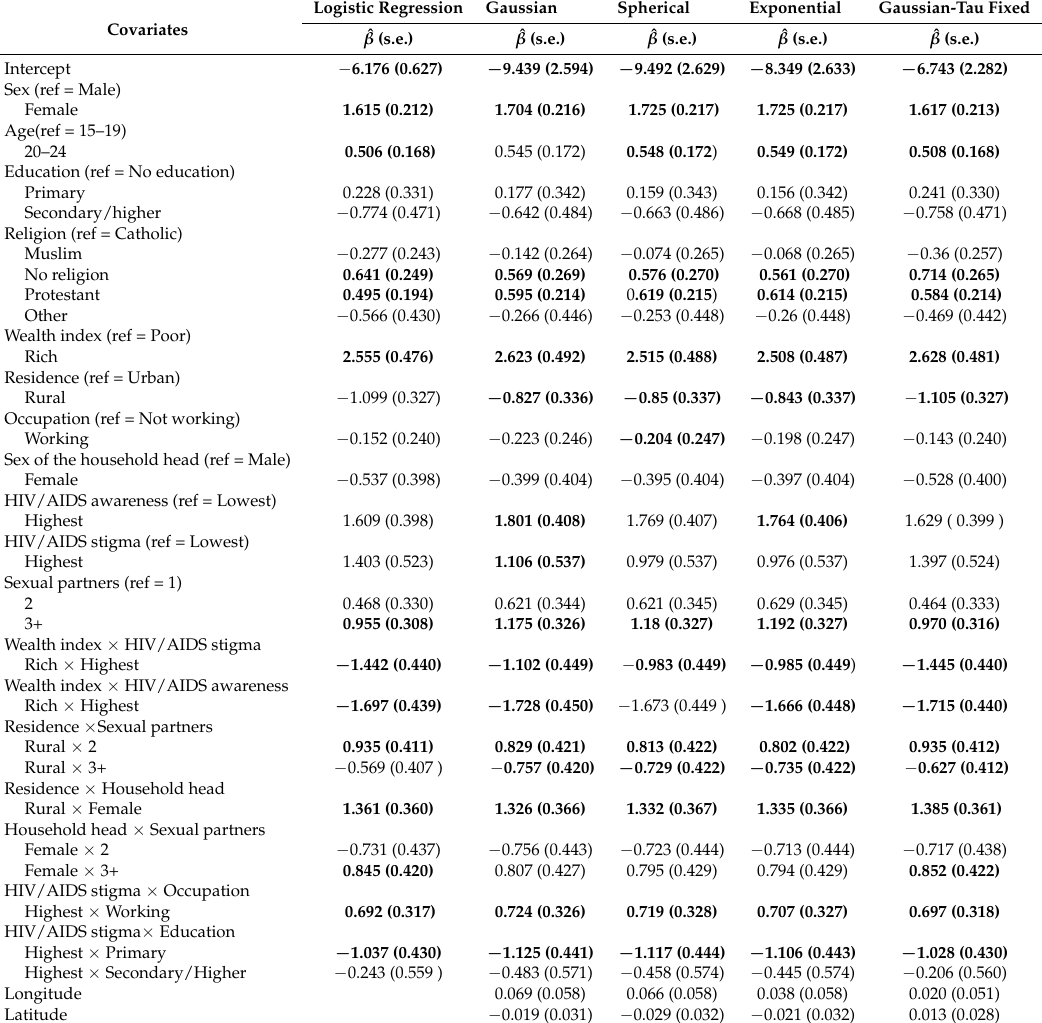
Table 4. Parameter estimates for multivariate logistic regression and generalized geoadditive model (logistic regression adjusted for spatial effect). The parameter estimates ˆ β are on natural log-odds scale, and between brackets standard errors (s.e.) are reported. Statistically significant coefficients are